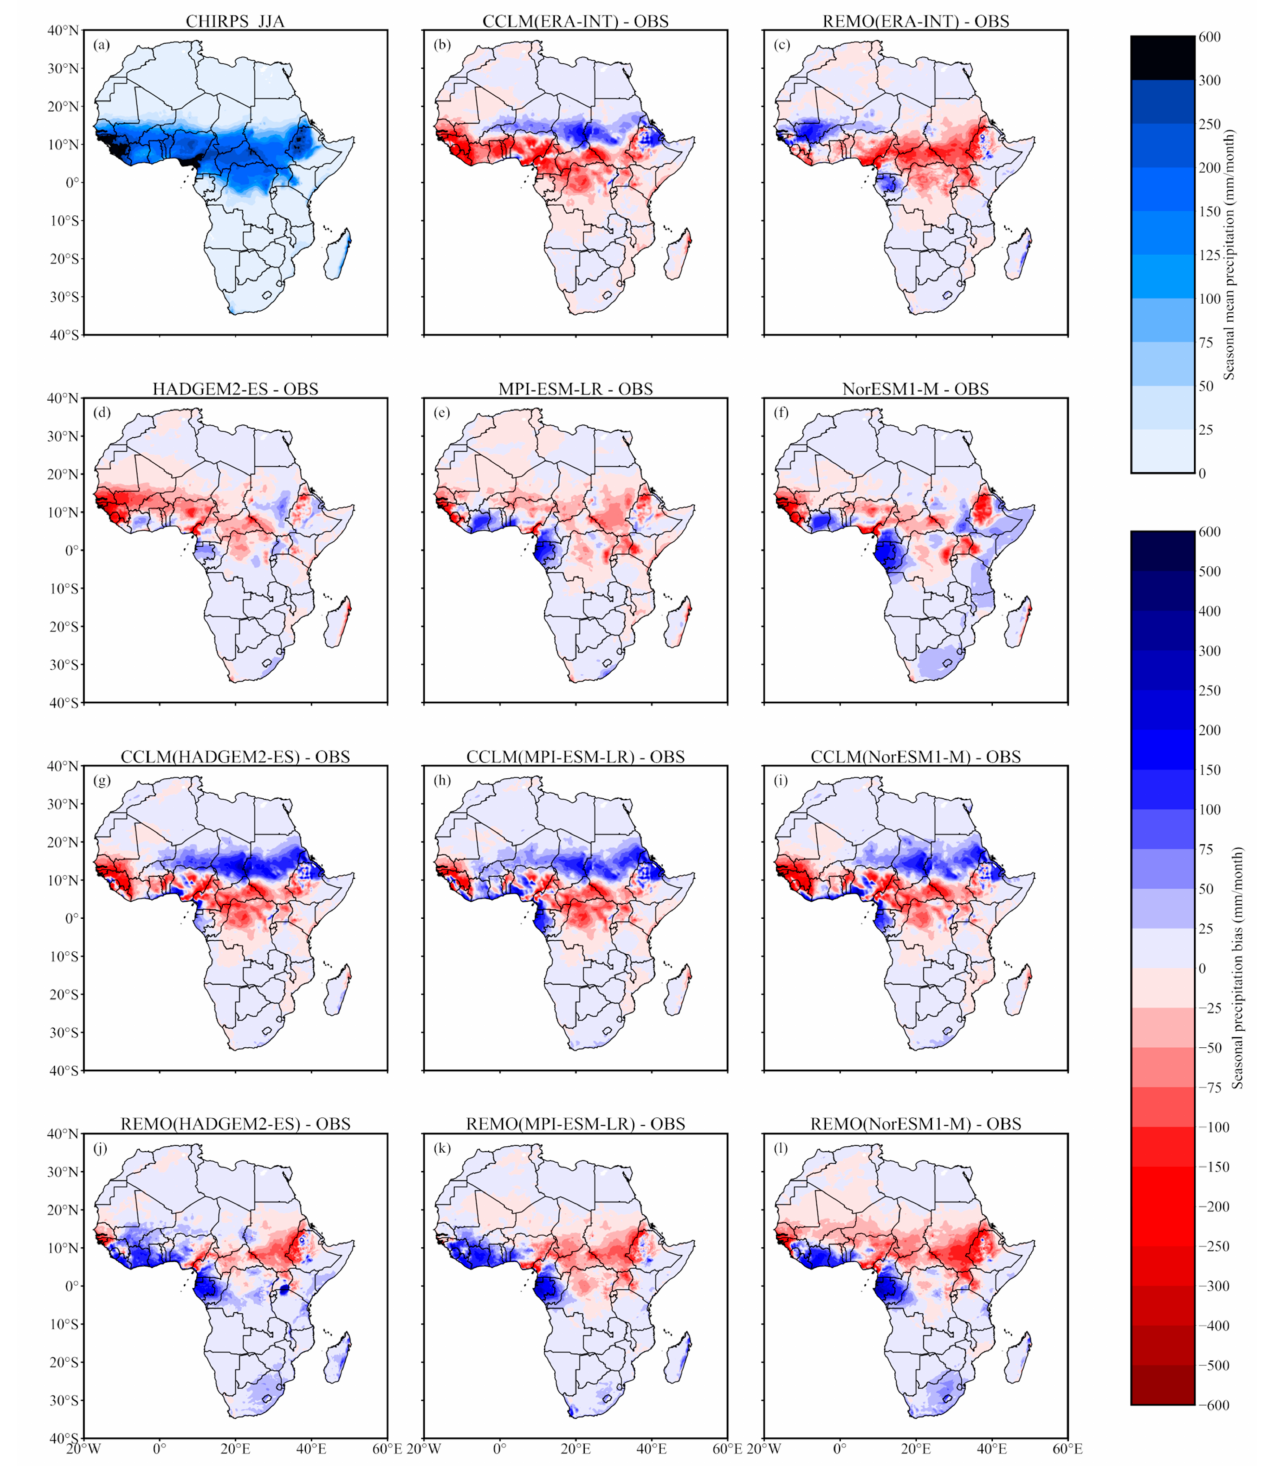
Figure 4. Bias of monthly precipitation in JJA, compared to CHIRPS, for GCMs, CCLM, and REMO: ( a ) CHIRPS ( b ) CCLM (ERA–INT)–CHIRPS, ( c ) REMO (ERA–INT)-CHIRPS, ( d ) HadGEM2–ES–CHIRPS, ( e ) MPI-ESM–LR–CHIRPS, ( f ) NorESM1– M-CHIRPS, ( g ) CCLM (HadGEM2–ES)-CHIRPS, ( h ) CCLM (MPI–ESM–LR)-CHIRPS, ( i ) CCLM (NorESM1–M)–CHIRPS, ( j ) REMO (HadGEM2–ES)–CHIRPS, ( k ) REMO (MPI–ESM–LR)–CHIRPS, ( l ) REMO